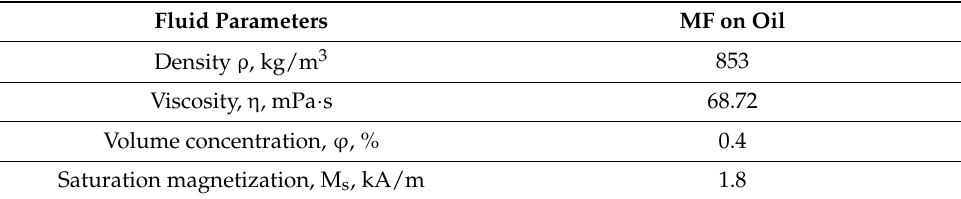
Table 2. Physical and chemical properties of magnetic